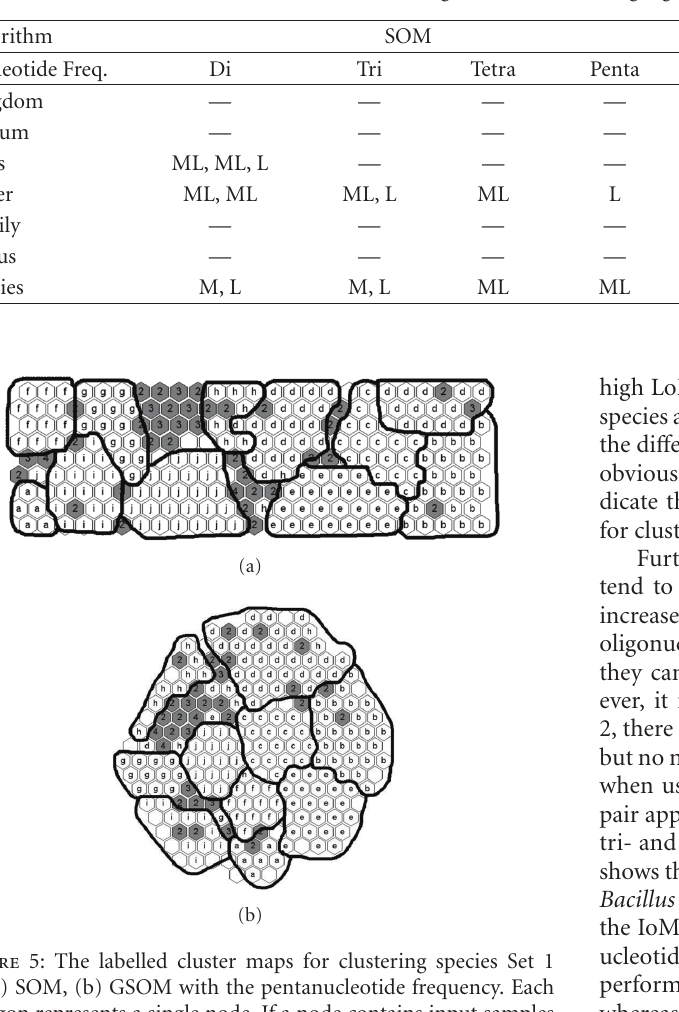
Table 3: Training results in the mixing regions for species Set 1.